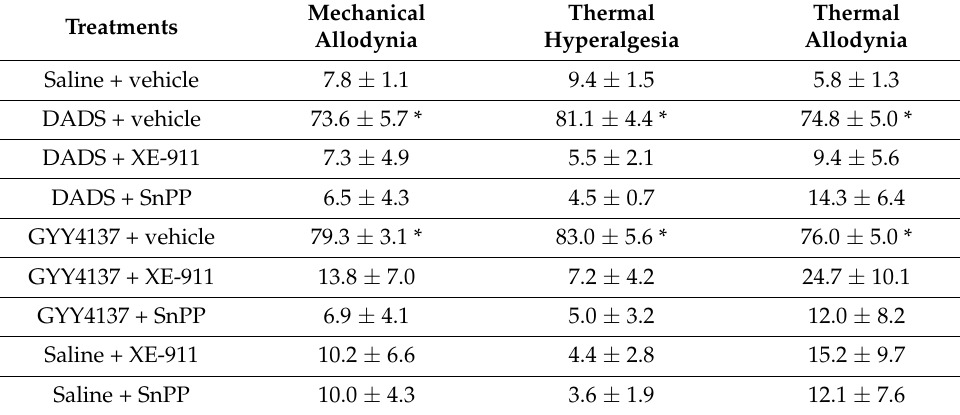
Table 2. Reversal of the effects produced by the acute intraperitoneal administration of 200 µ mol/kg of DADS or 64 µ mols/kg of GYY4137 with 8 µ mols/kg of XE-911 or 14.5 µ mol/kg of SnPP in the inhibition of the mechanical allodynia, thermal hyperalgesia and thermal allodynia induced by sciatic nerve injury in the ipsilateral paw. Data are expressed as mean ± SEM ( n = 6 animals per treatment). In each test, * denotes significant differences vs. saline + vehicle treated animals ( p < 0.05, one-way ANOVA, followed by the Student–Newman–Keuls